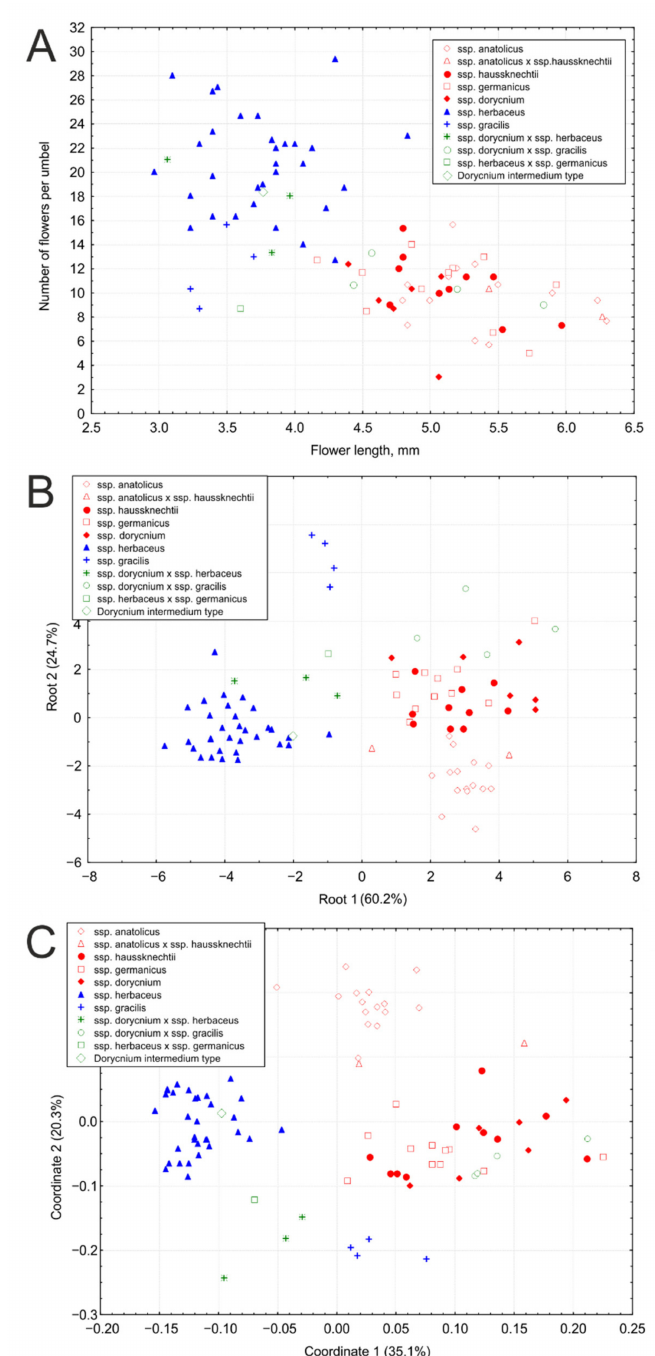
2. Red group: umbels with generally less numerous, but larger flowers; this group includes ssp. dorycnium , ssp. germanicus, ssp. anatolicus , and. ssp. haussknechtii .